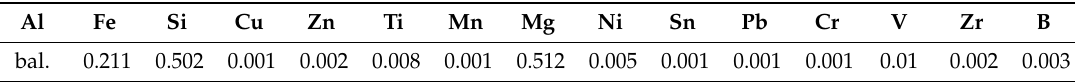
Table 1. Chemical composition of EN AW 6101 alloy investigated (wt. %).